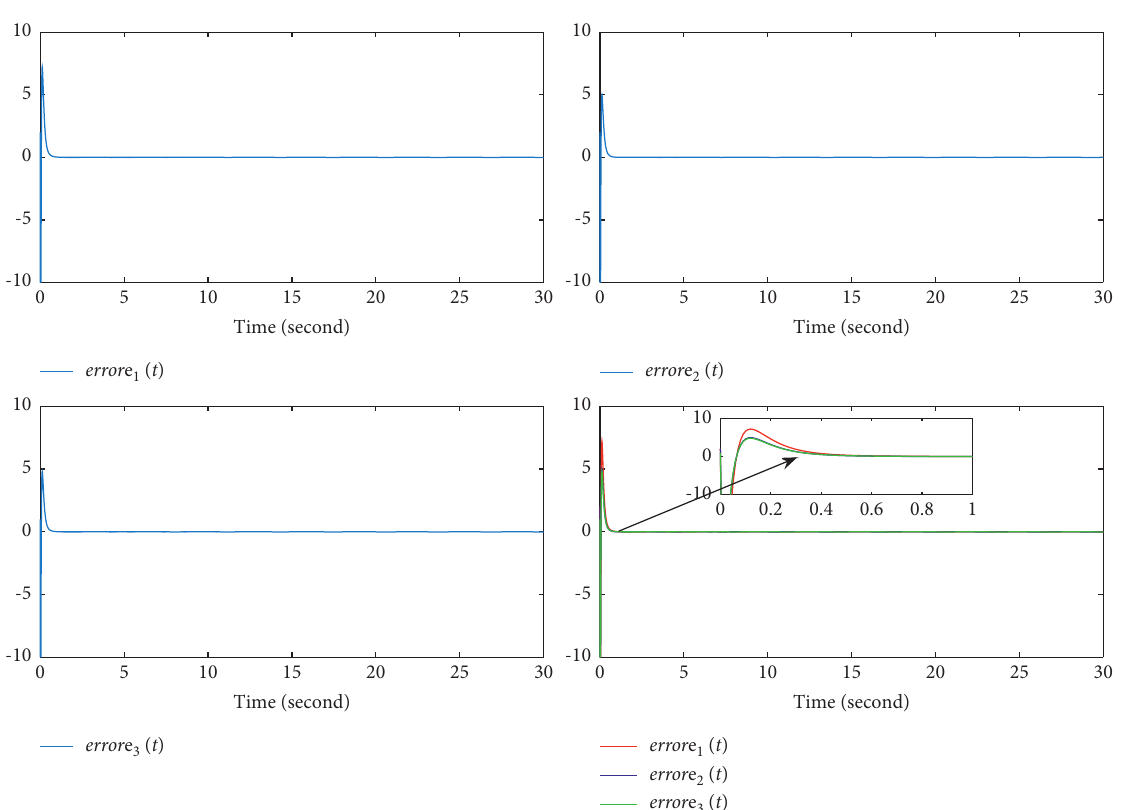
Figure 7: Synchronization errors e